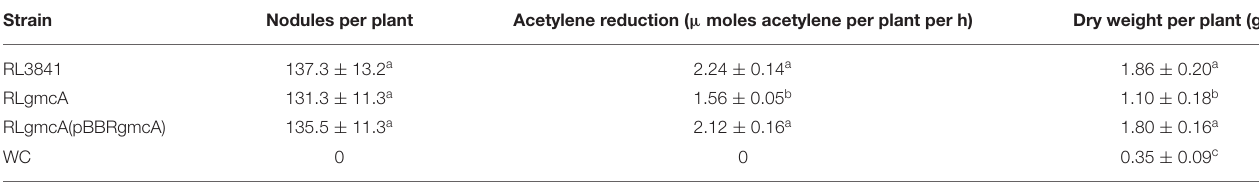
TABLE 4 | Symbiotic behavior of R. leguminosarum gmcA